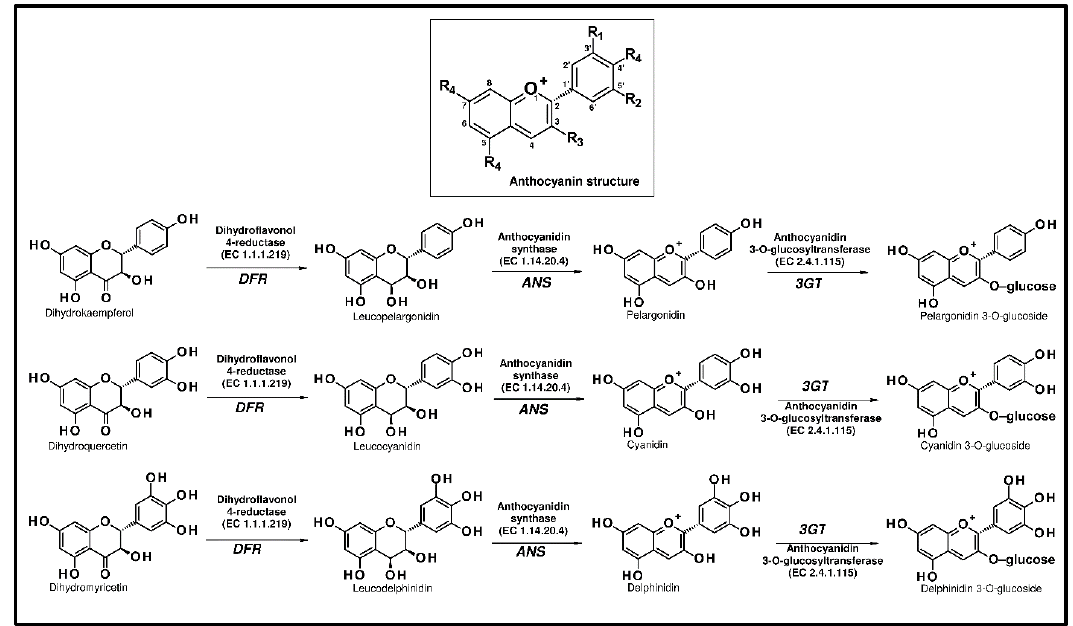
Figure 5. Anthocyanin structure and biosynthetic pathways (ANS, anthocyanidin synthase; DFR, dihydroflavonol 4-reductase; and 3GT, flavonoid 3- O -glucosyltransferase). Anthocyanins are produced in a specific branch of the flavonoid pathway. From naringenin, they are biosynthesized by flavanone 3-hydroxylase (F3H), dihydroflavonol 4-reductase (DFR, EC 1.1.1.219), and anthocyanidin synthase (ANS, EC 1.14.20.4). Anthocyanidin synthase has been characterized as